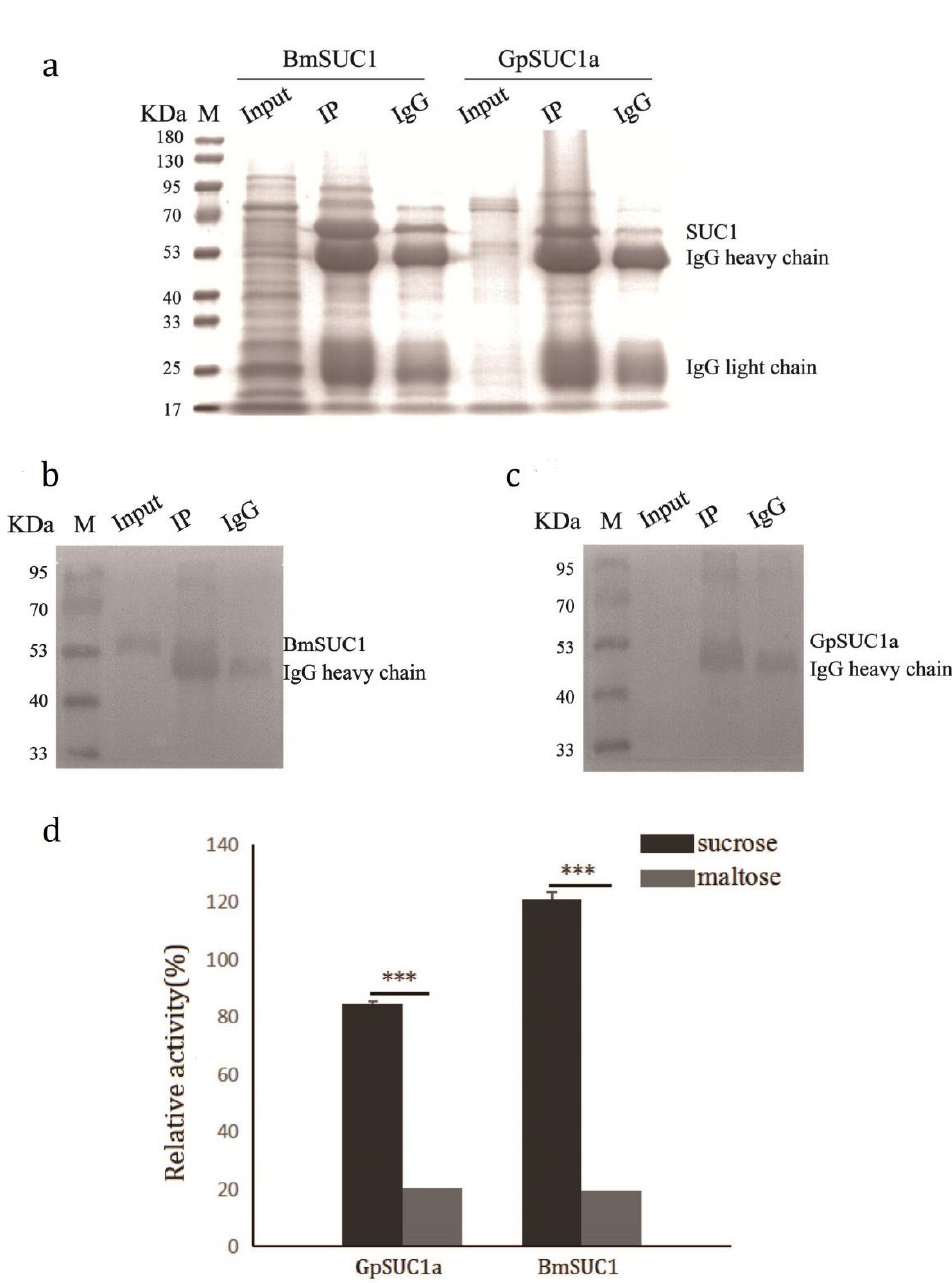
Figure 4. Confirmation of β -FFase activity in the larvae of GpSUC1a purified from the midgut. SDS-PAGE ( a ) and western blot ( b , c ) were used for analyzing the GpSUC1a in vivo. ( d ) Enzyme activity assays of the proteins in vivo. (Input: One Step Animal Tissue Active Protein Extraction Kit; IP: Purified protein with corresponding antibody added; IgG: Normal Rabbit IgG). Data are mean ± SEM ( n = 3, *** p < 0.001).